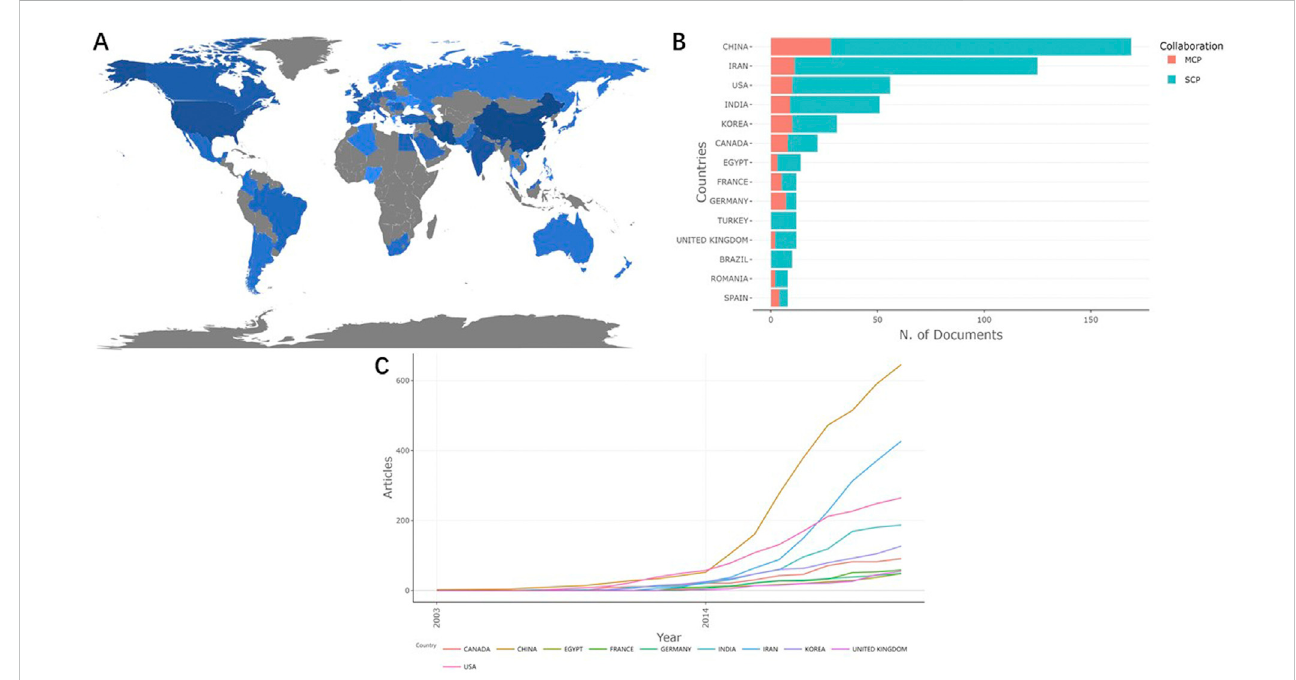
FIGURE 2 Contributions of different countries regarding the research of NHs applications for drug delivery. (A) Global country scienti fi c production contributions (The depth of color represents the number of articles published); (B) Top 10 countries with the highest productivity (based on the countries where the corresponding authors come from); (C) Production of the top 10 countries with the highest productivity over time.